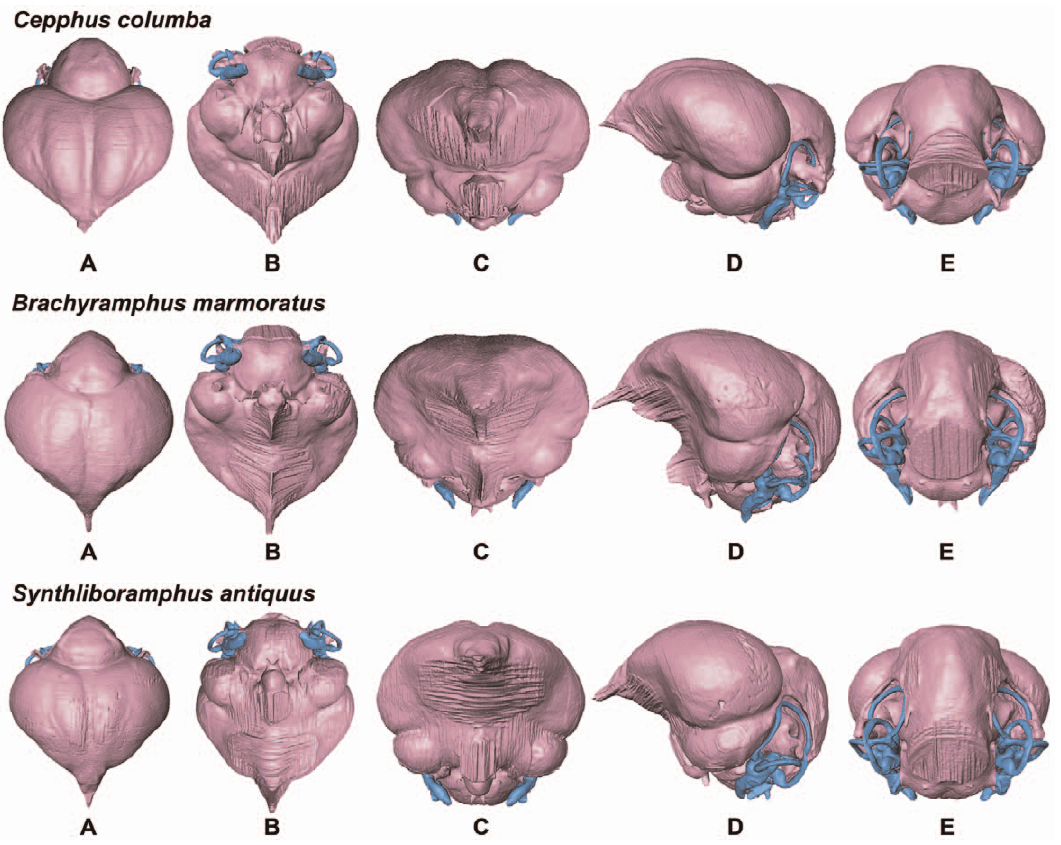
Figure 10. Endocasts of Pigeon Guillemot Cepphuscolumba , Marbled Murrelet Brachyramphusmarmoratus , and Ancient Murrelet Synthliboramphusantiquus in dorsal (A), ventral (B), anterior (C), lateral (D), and posterior (E) views (not to scale for comparison).